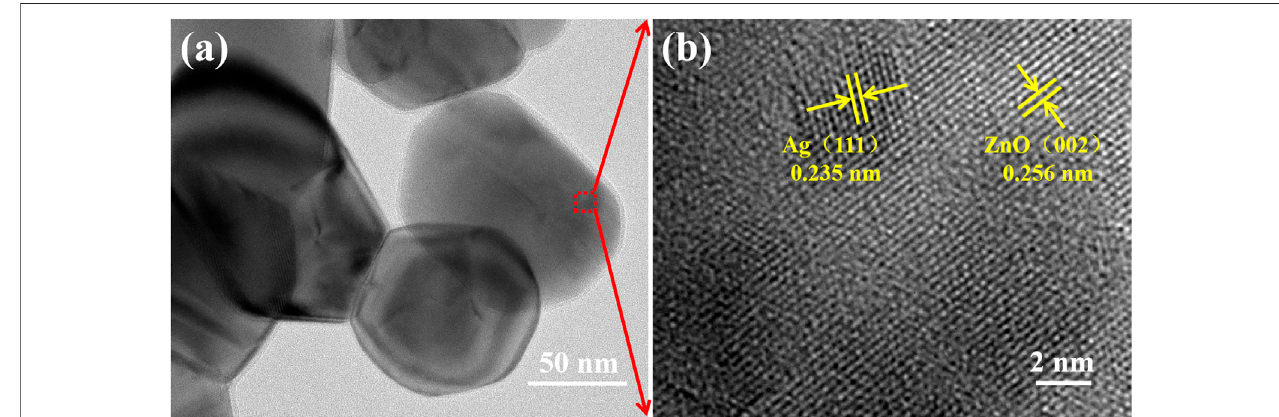
FIGURE 6 | TEM image of Ag/ZnO: (A) low-magni fi cation and (B) high-magni fi cation.